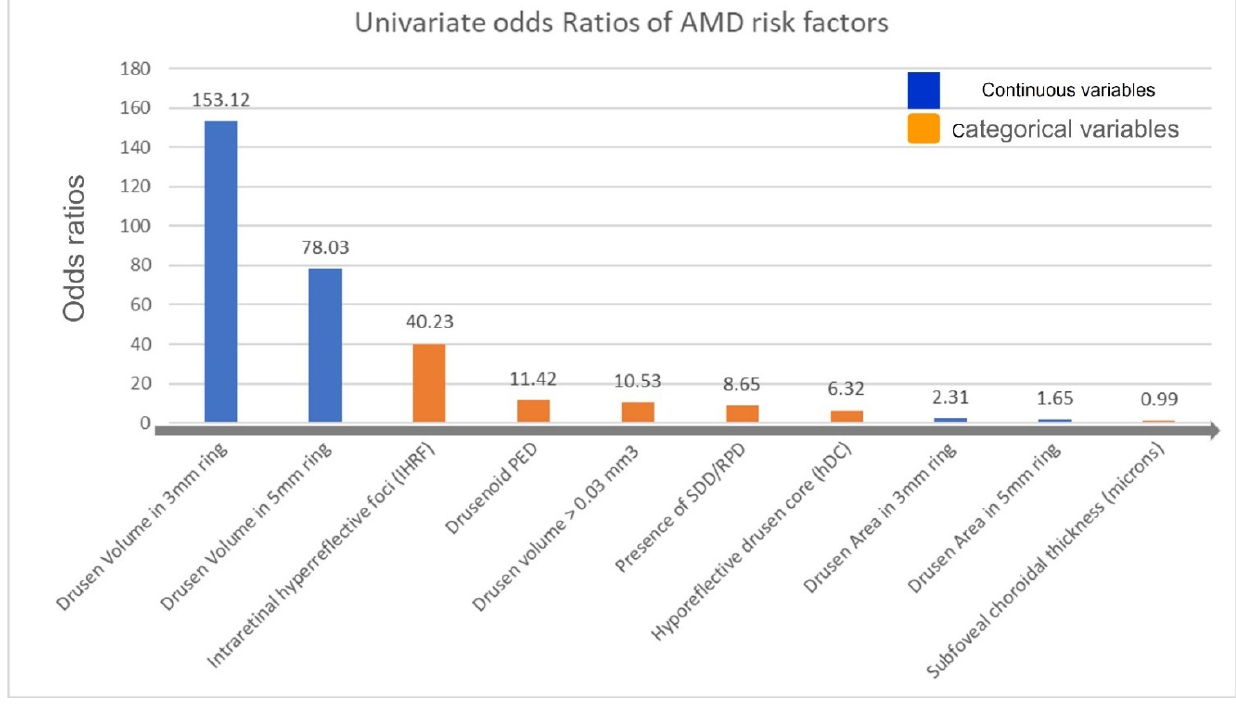
Figure 3. Bar plot showing the odds ratios from the univariate regression analysis (gray arrow indicates the direction of higher to lower risk for late AMD development). Table 1. Regression Analysis to Study the Effect of Various Biomarkers on GA incidence.